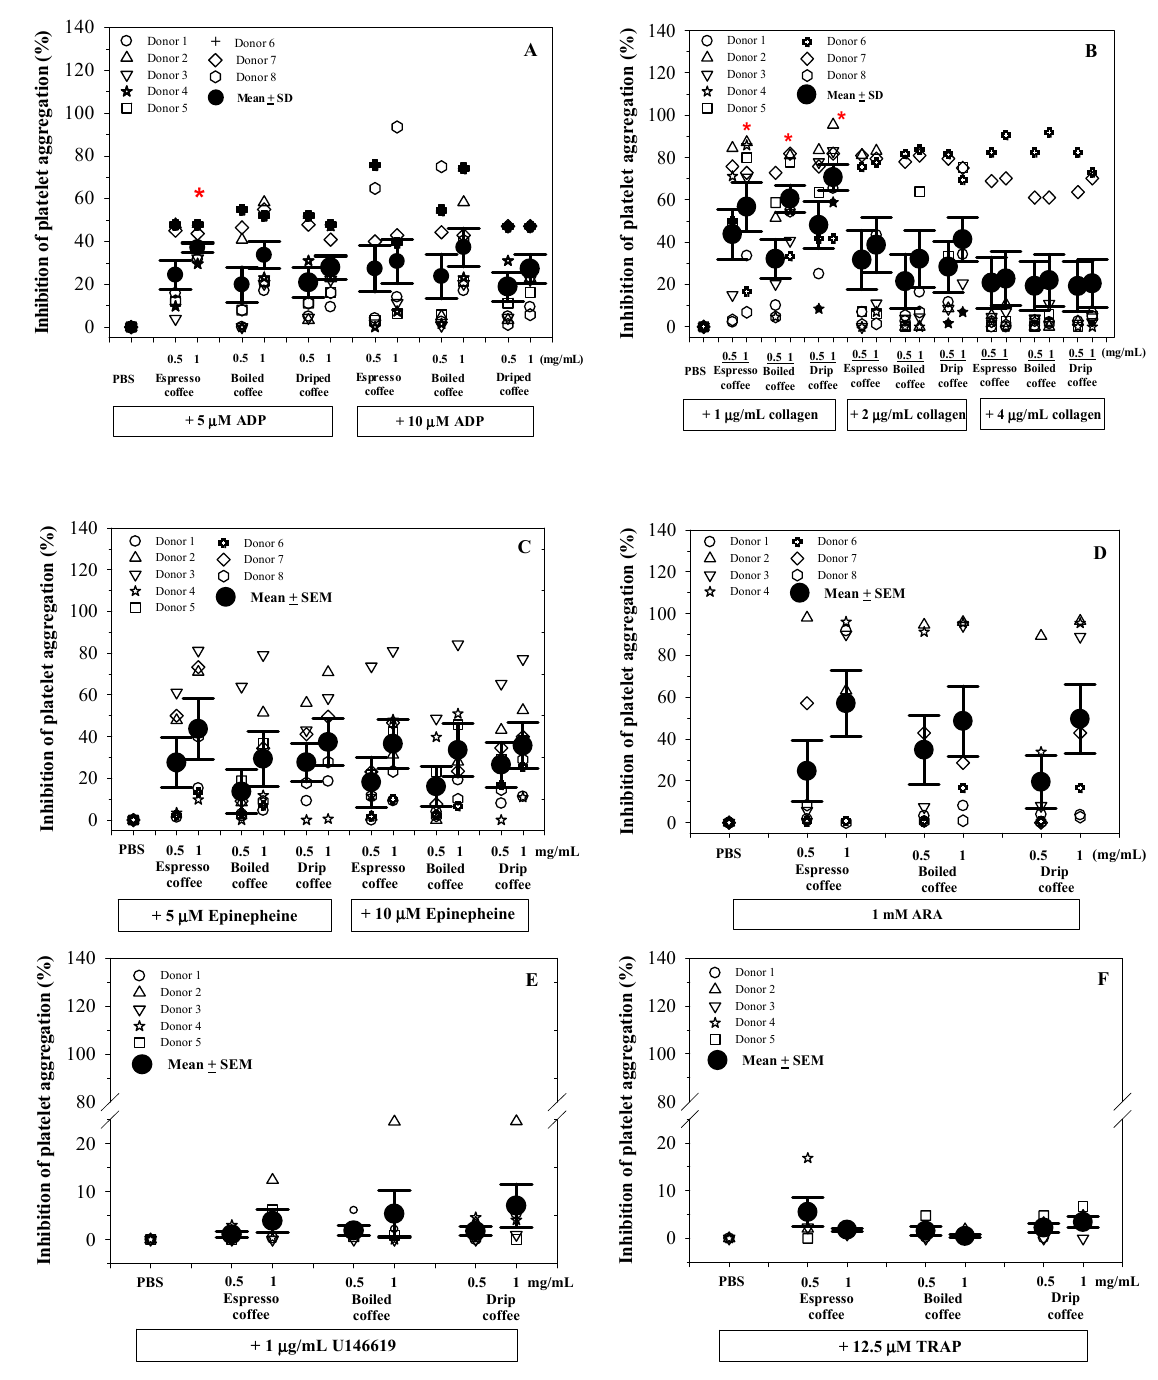
Figure 3. Inhibitory effects of phosphate-buffered saline (PBS) and coffee extracts (0.5 and 1 mg/mL each) on aggregation of platelets induced by adenosine diphosphate (ADP) ( A ), collagen ( B ), epinephrine ( C ), sodium arachidonate (ARA) ( D ), U46619 ( E ) and thrombin receptor agonist peptide (TRAP) ( F ). Data obtained from different blood samples are expressed as mean ± SEM values. * p < 0.05 when compared without the coffee extract treatments